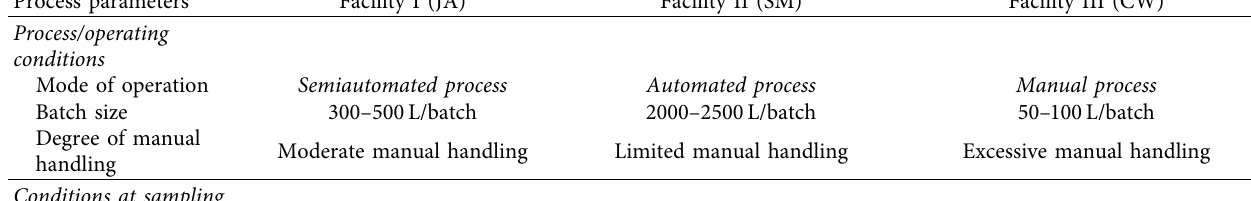
Table 2: Detailed description of observations made at each sampling point in the studied king coconut water processing facilities. Process